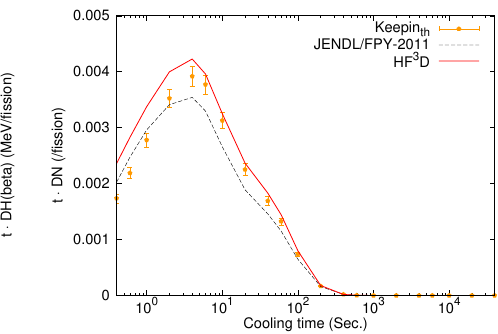
Figure 5. Cooling time dependence of the delayed neutron yield comparing with the experimental data for 235 U(n th